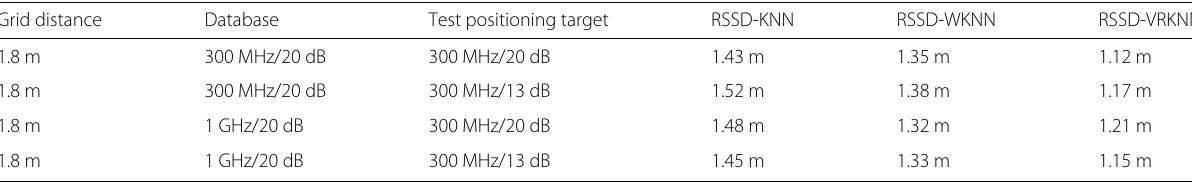
Table 4 Mean location errors of different algorithms Grid